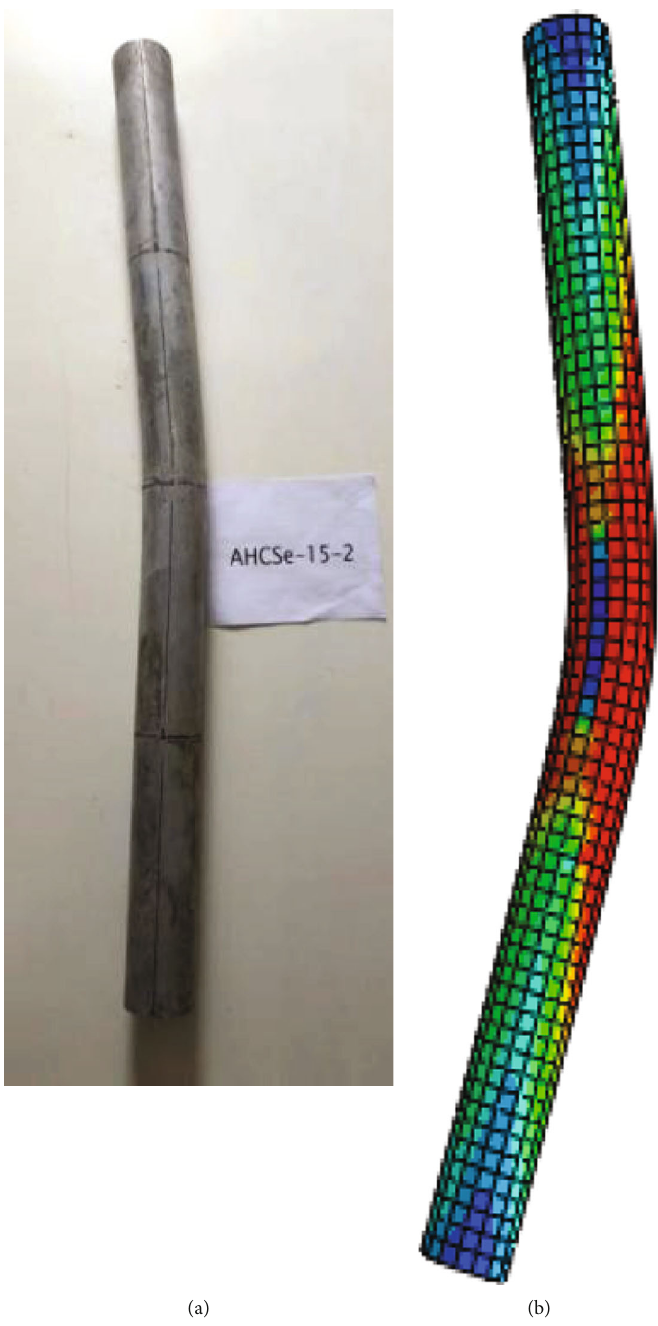
Figure 11: (a) Test failure mode. (b) Numerical analysis of failure